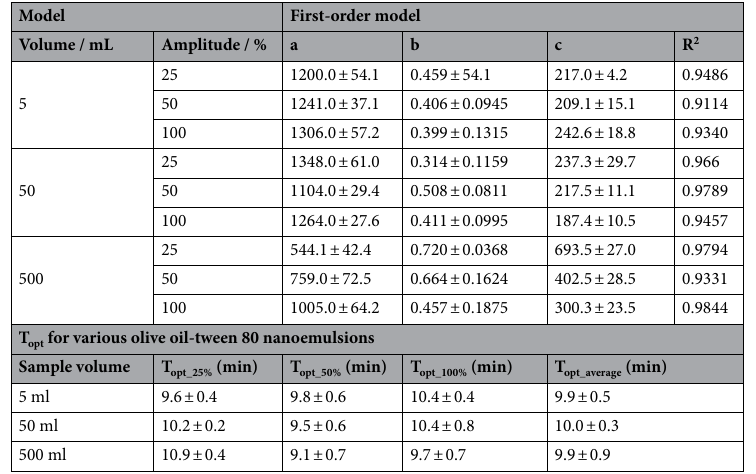
Table 4. First-order regression parameters of the olive oil-tween 80 nanoemulsions with different volumes under various ultrasonic amplitudes, along with their T opt